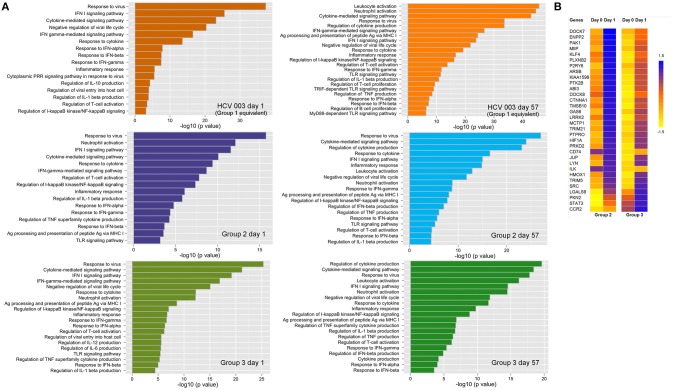
(A) Canonical pathway analysis modulated by differentially expressed genes (DEGs) that were upregulated 24 h post each vaccine administration: left panels—ChAd-vectored vaccines; right panels—MVA-vectored vaccines. The biological processes are depicted from DEGs in whole blood. The pathways are indicated on the y axis, and the x axis shows the significance score (negative log10 of p-value calculated using Fisher exact test). (B) Heatmap depicting expression of genes involved in locomotion (GO: 0040012), which are correlated with lymphocyte count decline on day 1. Groups 2 and 3 are shown separately but were pooled for statistical analysis as the change in lymphocyte count was similar in the two groups.